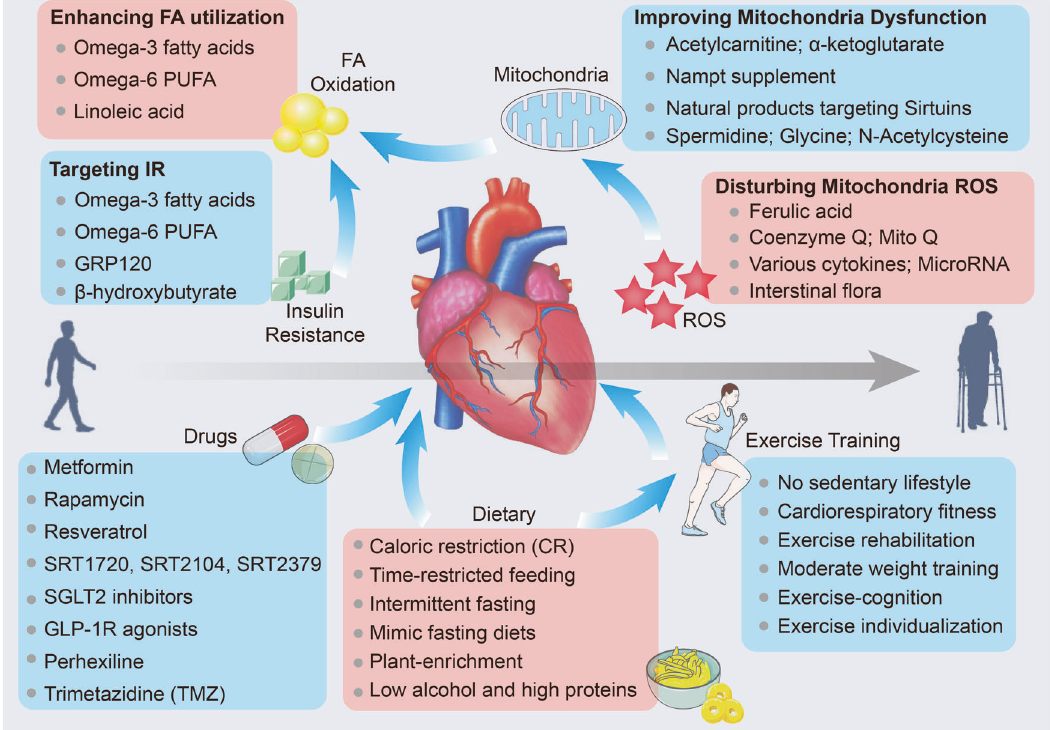
Fig. 6 Potential therapeutic approach for cardiac aging. Metabolic therapies for the treatment of cardiac aging are aimed to improve insulin resistance, FA oxidation, mitochondria dysfunction, and ROS. Synthetic small molecular drugs targeting insulin resistance, sirtuin activation, and ROS clearance are veri fi ed to delay cardiac aging in animal model. Moreover, both dietary advice and exercise training are bene fi cial for cardiac aging in the elderly. The online resource inside this fi gure was quoted or modi fi ed from Servier Medical